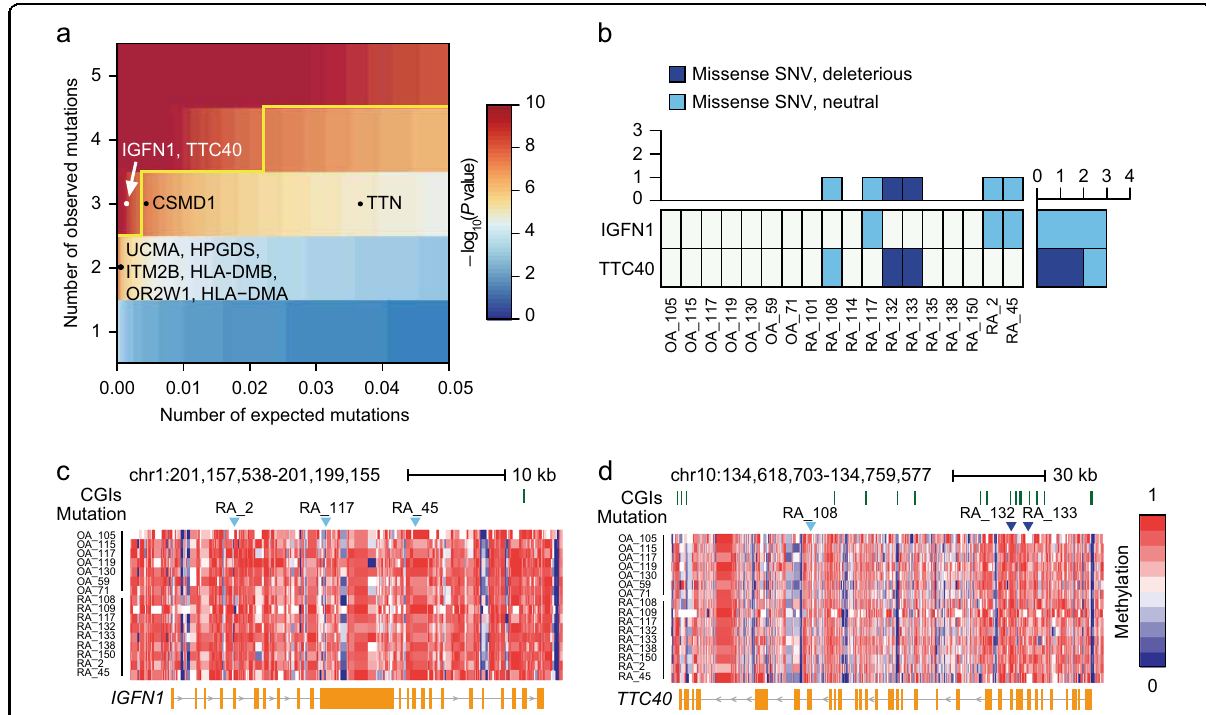
Fig. 6 Identi fi cation of signi fi cant rare genetic variants. By analyzing RA and OA exome sequencing data, sites and frequency of variants were identi fi ed. a A heatmap showing signi fi cance levels of detected variants. Degrees of signi fi cance levels are color scaled. White points are signi fi cant variants, and black points are not signi fi cant. A yellow line describes the cutoff. b A heatmap showing the number of variants in each sample. c The methylation pro fi le along the IGFN1 gene locus is shown color scaled from blue (low) to red (high). CpG islands (CGIs) are marked by green ticks above the heatmap. Sites of variants are shown in blue triangles. d The chromosomal position, CGI location, sites of variants, and methylation pro fi le are depicted in the TTC40 gene